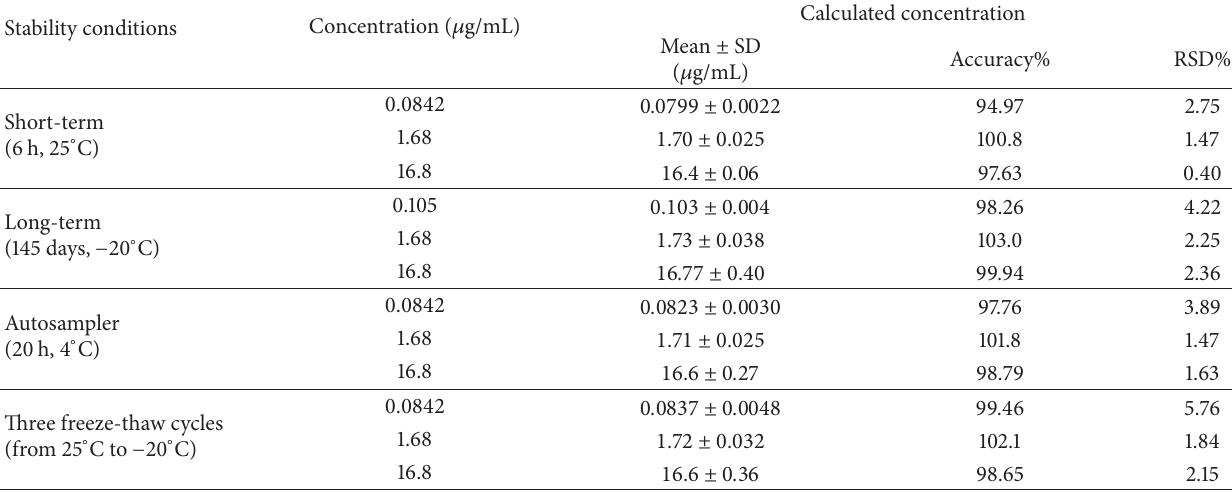
Table 2: Summary of the stability of cefuroxime in human plasma on different conditions (𝑛 = 3) .